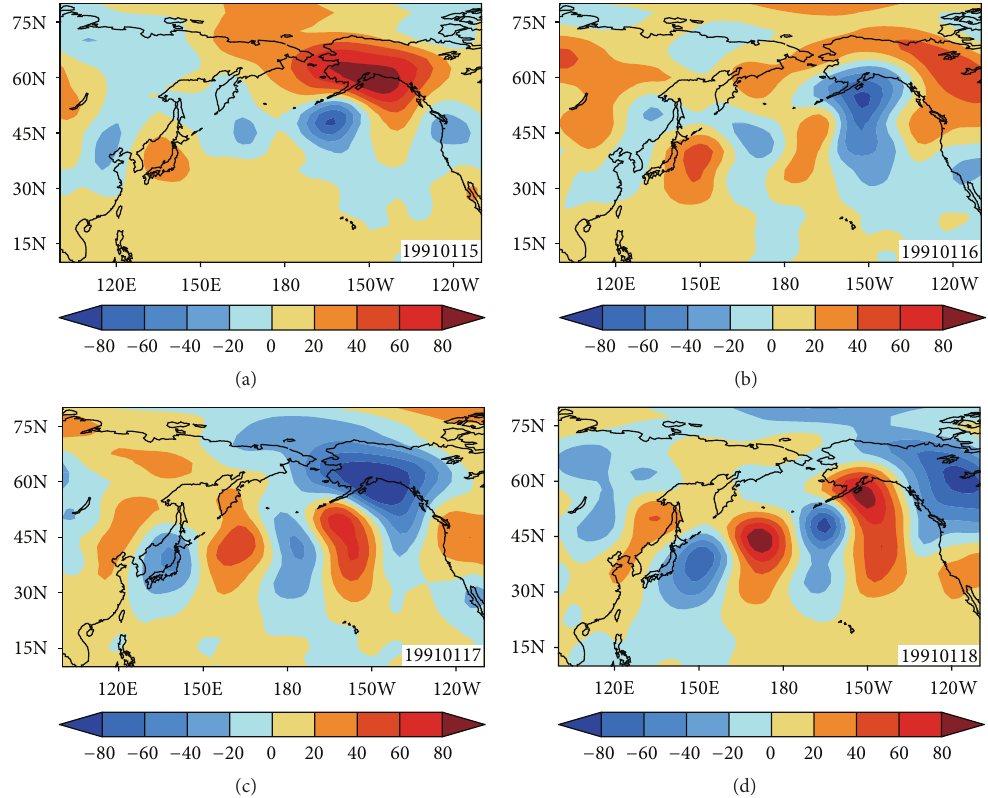
Figure 6: The synoptic-scale geopotential height perturbations at 850 hPa from 15 to 18 January 1991 (unit: gpm).